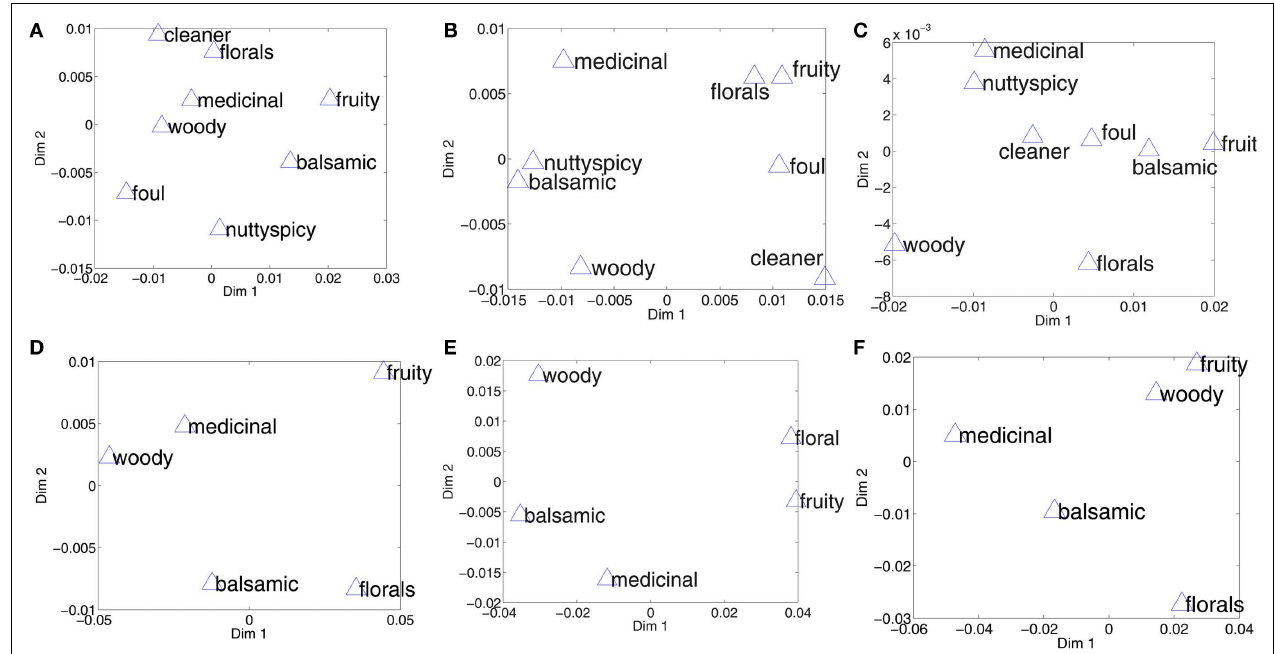
FIGURE 6 | Perceptual spaces constructed from pair-wise distances reduced to two dimensions by multi-dimensional scaling. (A) Shows the perceptual space in Chrea (2004), as per Zarzo (2008). (B) Shows the space as given by the distances from spatial encodings. (C) Shows the space as given